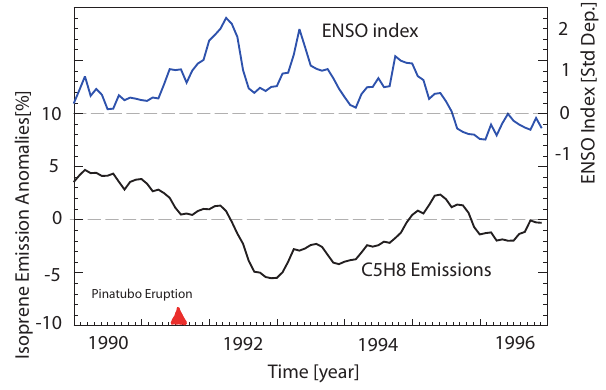
Fig. 1. Anomalies in global isoprene emissions (black line). A six month running mean is applied to show the long term trends. The ENSO index of Wolter and Timlin (1993) is included for reference (blue line). The reduction in emissions after the eruption of Mt Pinatubo (marked by a red triangle) is clear.